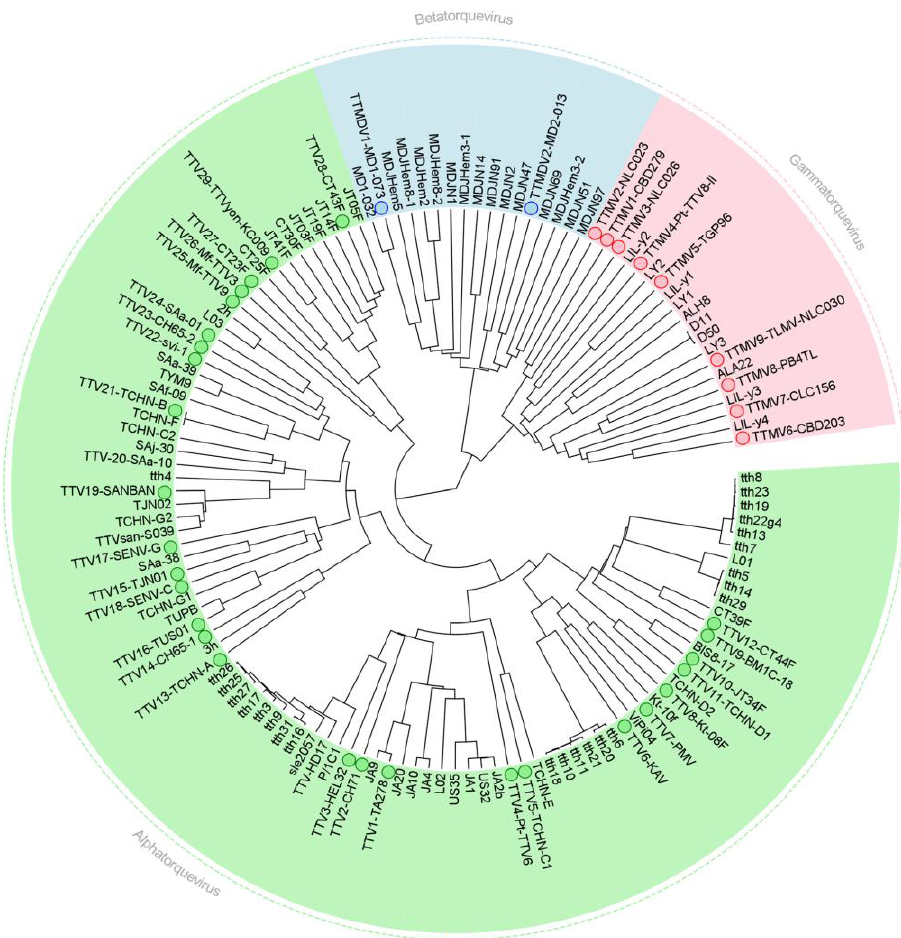
Figure 2 : The diagram demonstrates the three main species of Annelloviruses which are: Alphatorquevirus for TTV, Betatorquevirus for TTMDV and Gammatorquevirus for TTMV. All three Annelloviruses are different in terms of the size (bp). The image is taken from Spandole et al.,2015.